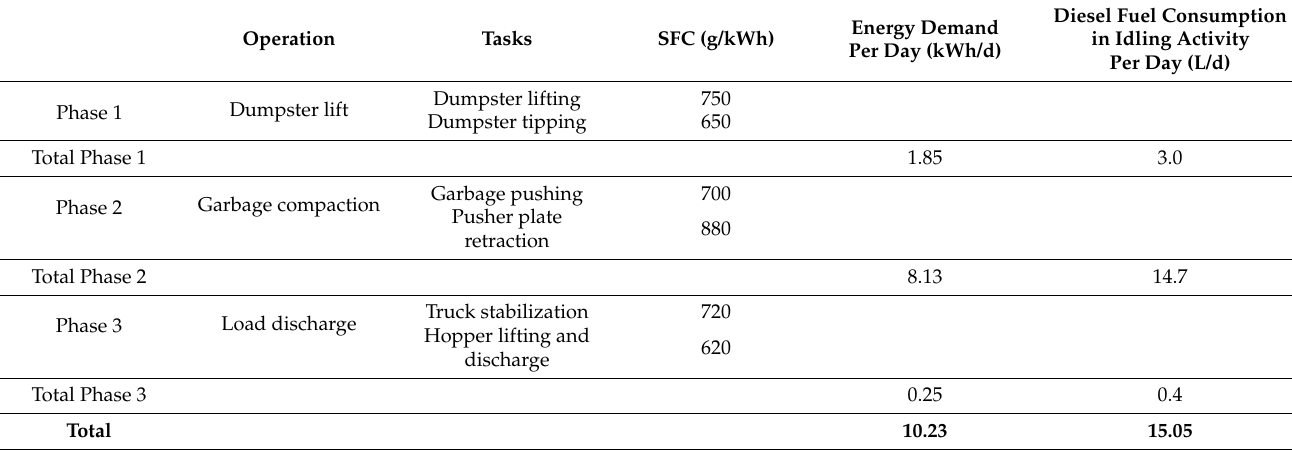
Table 3. Energy demand and diesel fuel consumption for the compactor truck for the considered collection